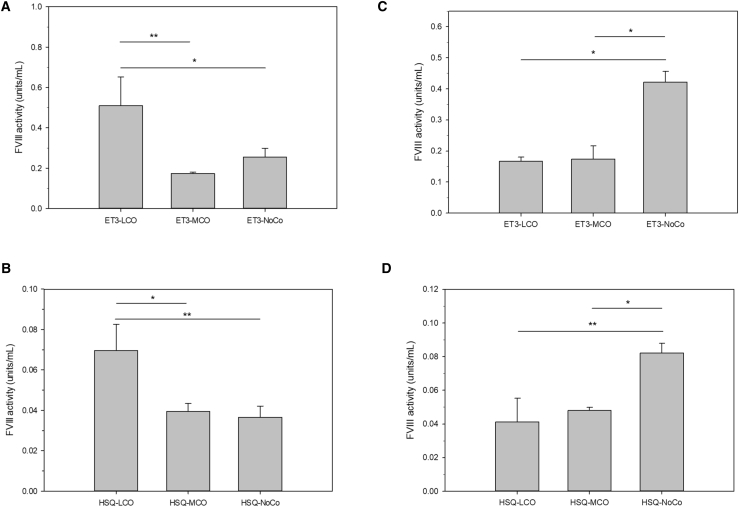
Expression and Tissue Specificity of LCO, MCO, and NoCo Designs(A and B) HepG2 cells were transfected with (A) ET3-LCO-, ET3-MCO-, and ET3-MCO-encoding plasmids and (B) HSQ-LCO-, HSQ-MCO-, and HSQ-NoCo-encoding plasmids. fVIII activity in the conditioned media was measured 48 hr after transfection. In (A), *p = 0.011 and **p = 0.006, and in (B), *p = 0.006 and **p = 0.005 by one-way ANOVA and the Holm-Sidak method. (C and D) BHK cells were transfected with (C) ET3-LCO-, ET3-MCO-, and ET3-MCO-encoding plasmids and (D) HSQ-LCO-, HSQ-MCO-, or HSQ-NoCo-encoding plasmids. In (C), *p < 0.001, and in (D), *p = 0.007 and **p = 0.004 by one-way ANOVA and the Holm-Sidak method. Data are presented as the mean ± sample SD.